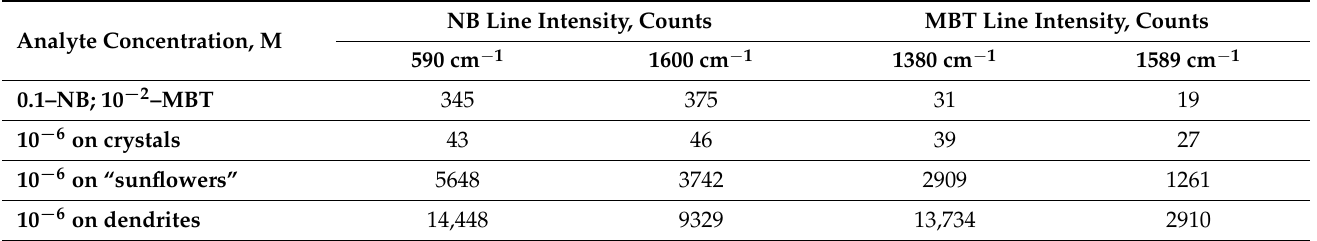
Table 2. Intensity of characteristic lines for NB and MBT obtained by Raman and SERS methods.